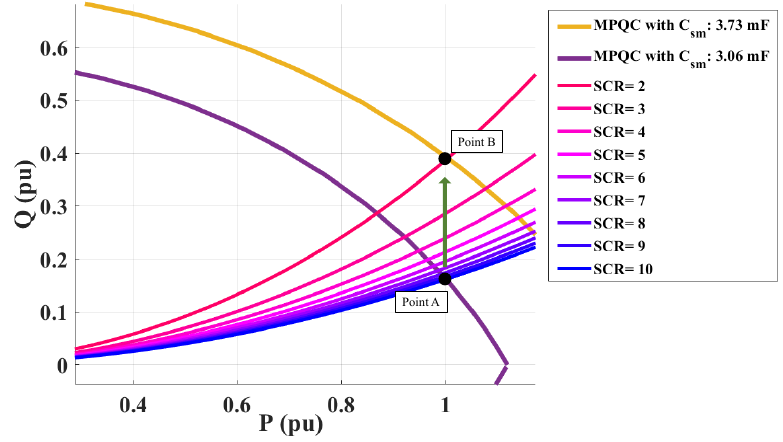
Figure 8. Change in PQ loading curves of MMC with different short circuit ratio